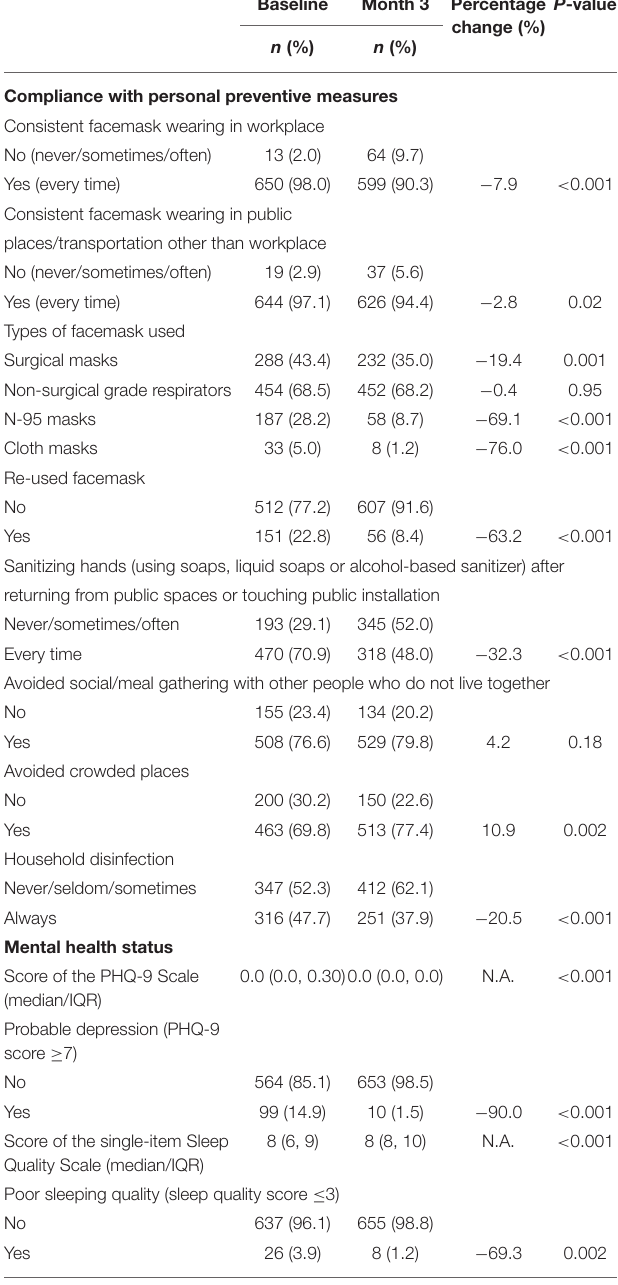
TABLE 2 | Changes in personal preventive measures and mental health status.